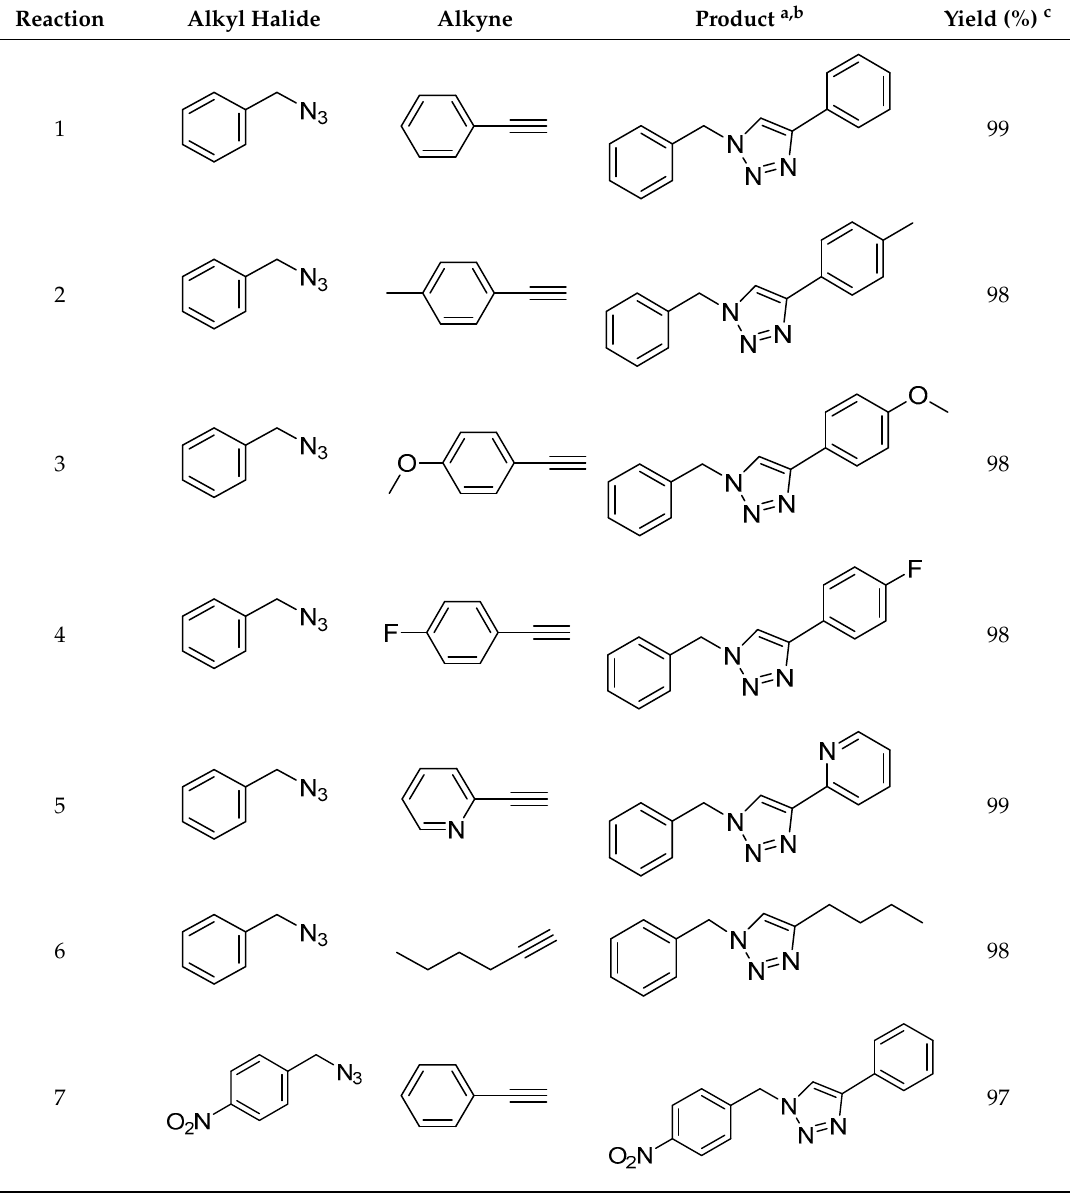
Table 1. Huisgen “click” reactions using Cu 2 O@L.